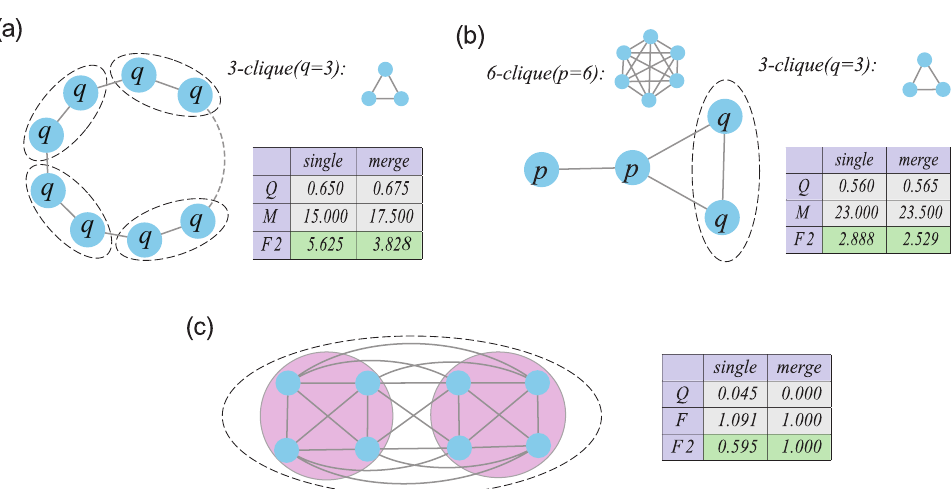
Figure 1. Performances of different objective functions on several representative networks. ( a ) Several 3-cliques connected to a ring through single edges (Reprinted/adapted with permission from Ref. [36], Copyright (2007) National Academy of Sciences, U.S.A.). On this network, two candidate community structures are generated. One is to identify each q -clique as a single community. The other is to merge each pair of adjacent cliques into one community. The values of modularity functions Q , M and F 2 for these two structures are listed as ‘single’ and ‘merge’ when the network contains 10 3-cliques in the inserted table. ( b ) A network consisting of two 6-cliques and two 3-cliques (reprinted/adapted with permission from Ref. [36], Copyright (2007) National Academy of Sciences, U.S.A.). ‘Single’ in the inserted table refers to identifying each clique as an individual community, while ‘merge’ refers to the integration of the two 3-cliques. ( c ) A well-connected network which is more compact than networks of Figure 1 in Ref. [40]. “single” splits the network into two communities, while “merge” identifies the whole network as one